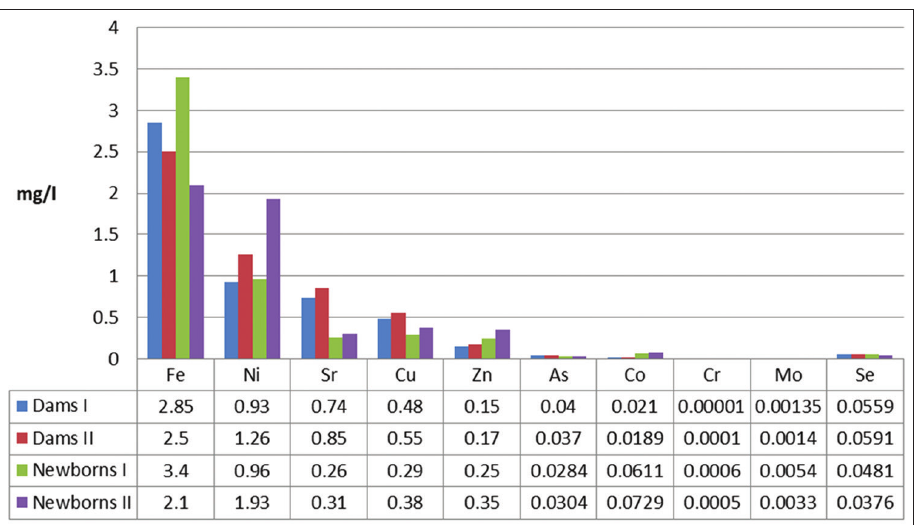
Figure-2: Microelements content in the blood serum of down-calving cows and newborn calves (median indicator